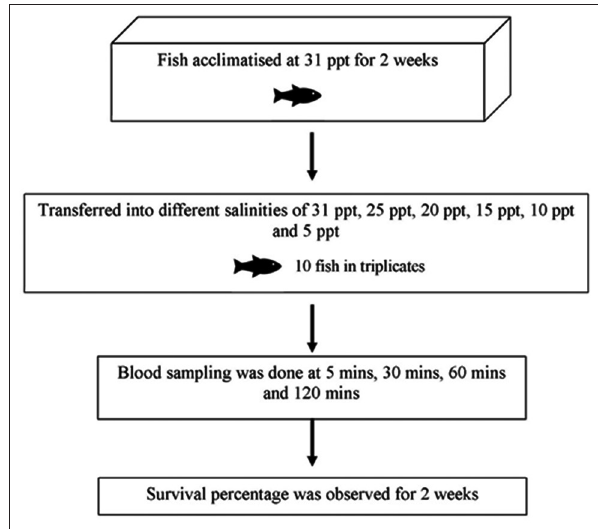
Figure-1: The experimental design for measuring serum cortisol level in Epinephalus fuscoguttatu s exposed to different salinities. Two hundred fingerlings were acclimatized in a 500 L tank with 31 ppt salinity for 2 weeks. After acclimatization, 10 fish were introduced into each tank containing 22 L seawater adjusted at different salinities of 31 ppt, 25 ppt, 20 ppt, 15 ppt, 10 ppt and 5 ppt with triplicates. Blood sampling was done after 5, 30, 60 and 120 min. followed by observation for survival percentage for two